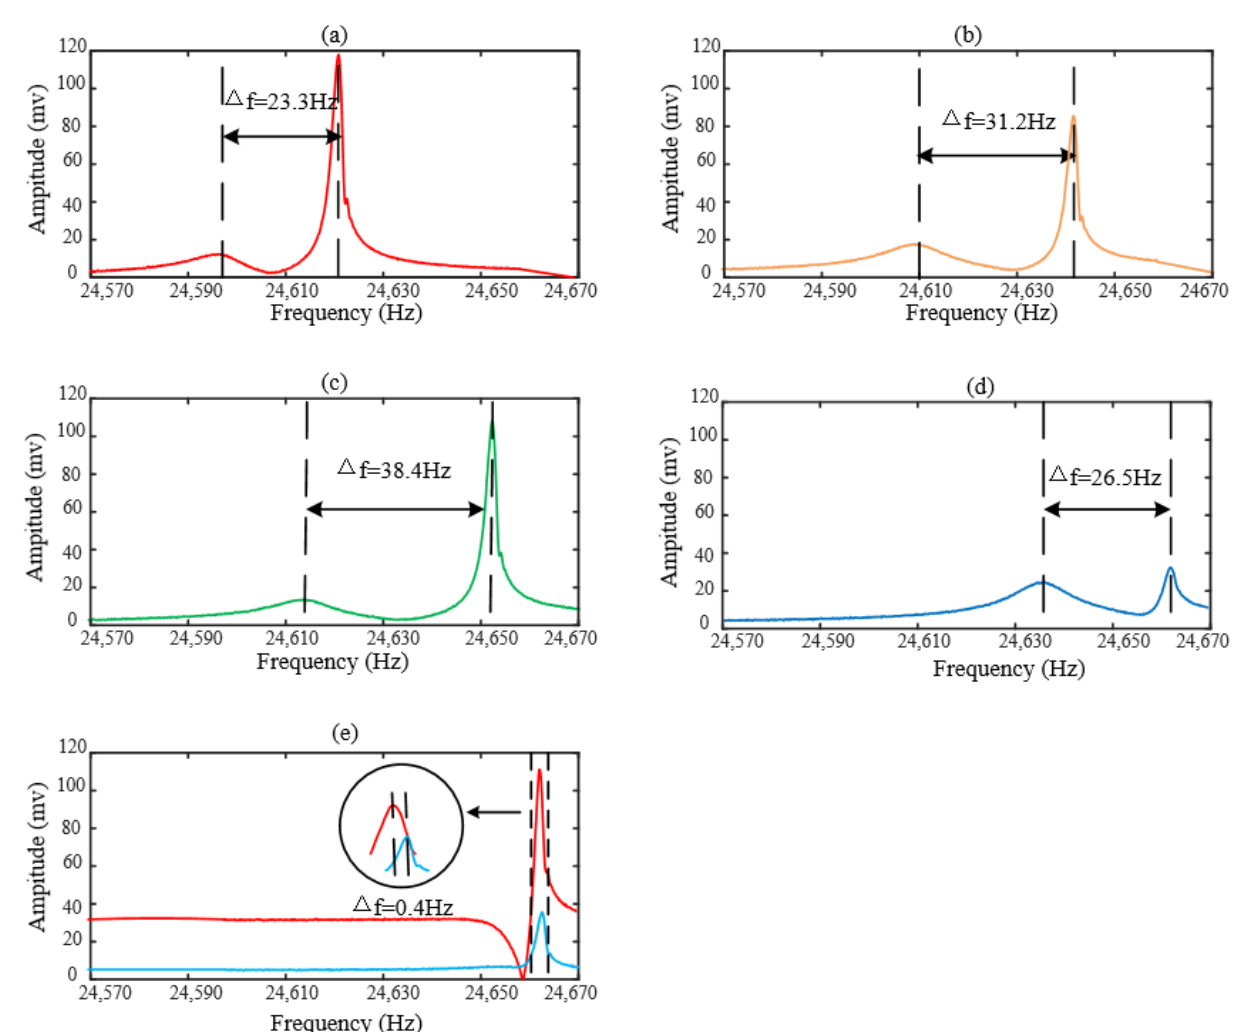
Figure 10. Frequency sweep of tuning process. ( a ) The initial frequency sweep; ( b ) Frequency sweep after the first time of tuning; ( c ) Frequency sweep after the second time of tuning; ( d ) Frequency sweep after the third time of tuning; ( e ) Frequency sweep after the fourth time of tuning.